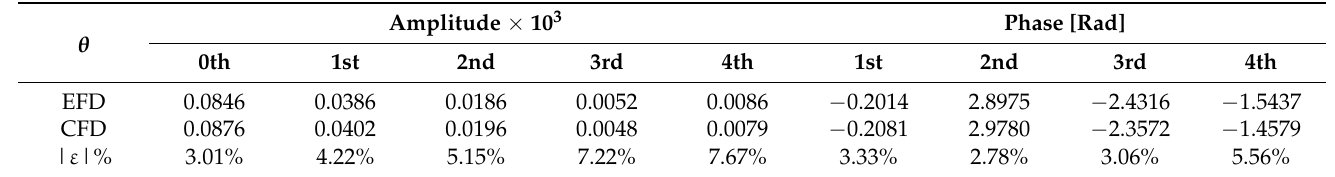
Table 18. Harmonic amplitudes and phases of pitch ( θ ) for the FRxz ϕθ beam waves